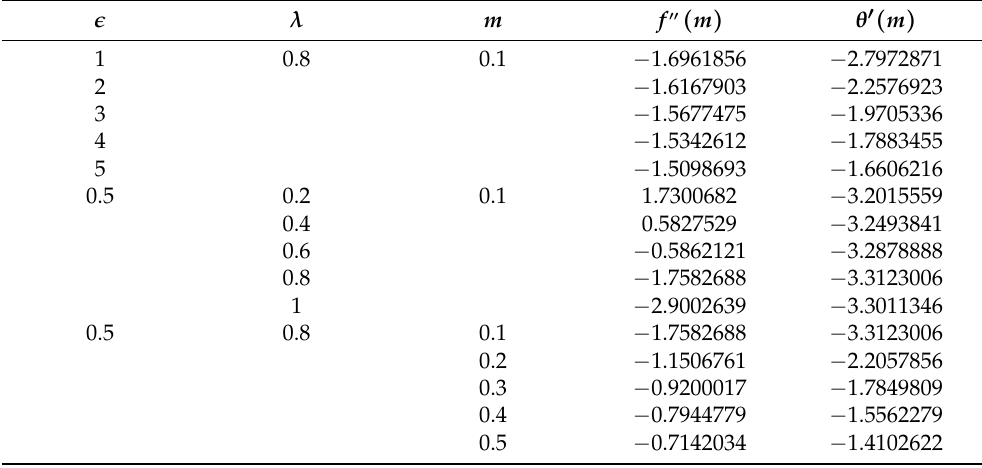
Figure 9. Graphical representation of f (cid:48)(cid:48) ( 0.1 ) and θ ( 0.1 ) for different choices of the parameter Pr when m = 0.1, λ = 0.3 and θ w = 1.27. Part ( a ) shows function f (cid:48) , while the function θ is plotted in part ( b ). Table 2. Numerical values of f (cid:48)(cid:48) ( m ) and θ (cid:48) ( m ) for different values of parameters when Pr = 5 and θ w = 1.27. Results are included for the exponential temperature dependency (case A)